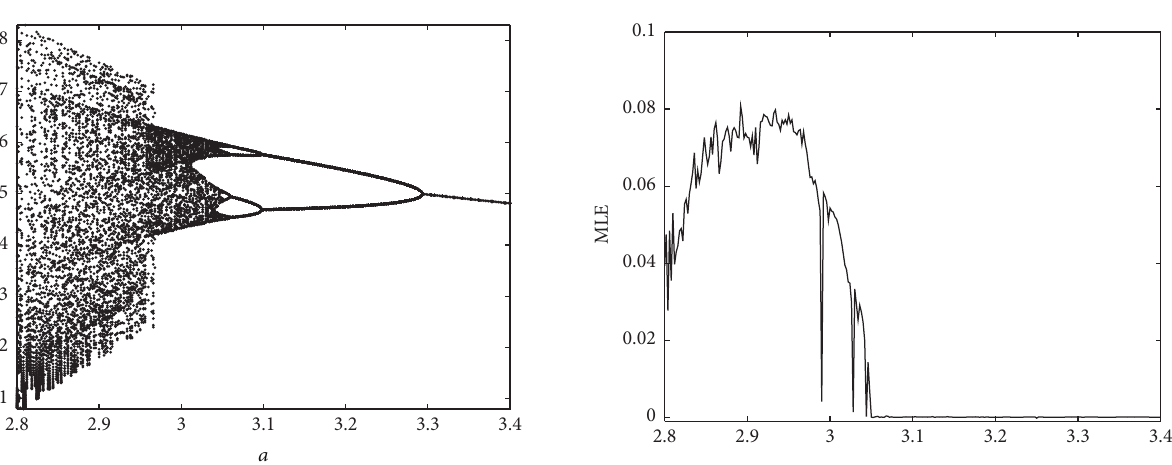
Figure 3: Maximal Lyapunov exponents of system (1) with respect to the bifurcation parameter 𝑎